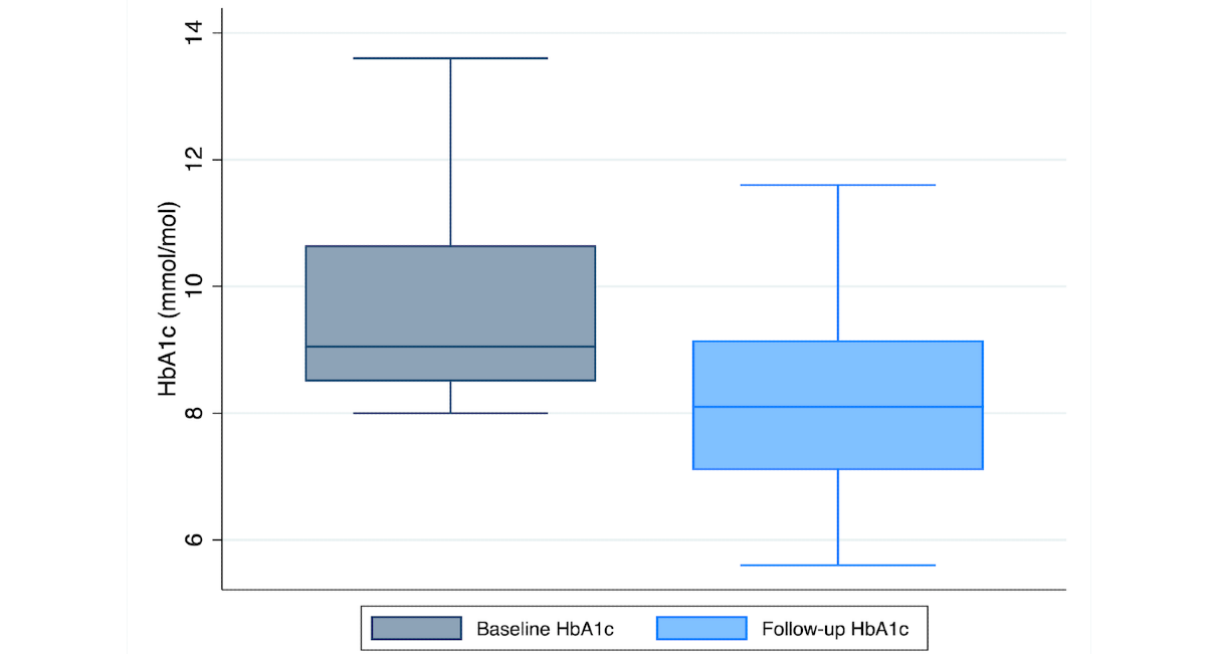
Figure 4. A boxplot of change in HbA 1c from baseline to follow-up among high-risk participants with a baseline HbA 1c ≥ 8 (N=140). HbA 1c : hemoglobin A 1c